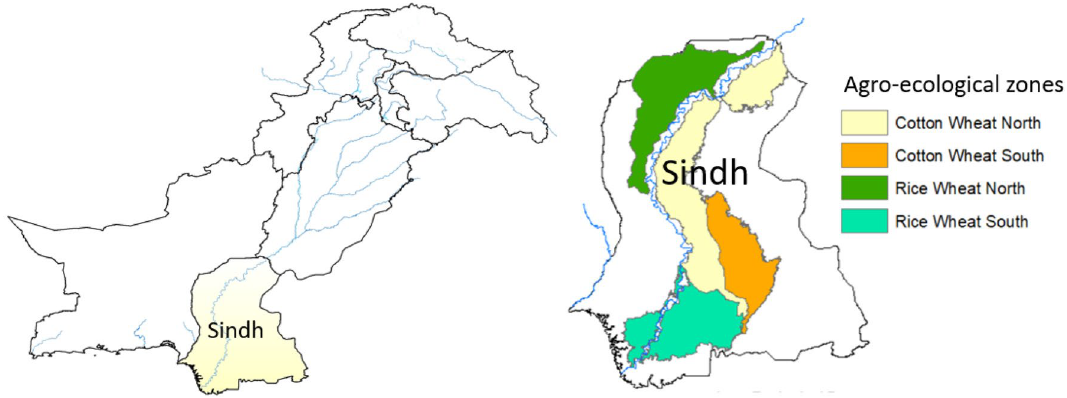
Figure 2. Location map of the study area and crop production zones in the Sindh Province of Pakistan, the maps were produced using the ArcGIS 10.7 (www. esri. These data sets were used for relating the satellite-based rainfall estimates with ground observations. The daily rainfall estimates were also aggregated at the monthly interval to understand the spatial patterns of monthly accumulated rainfall during August 2022.